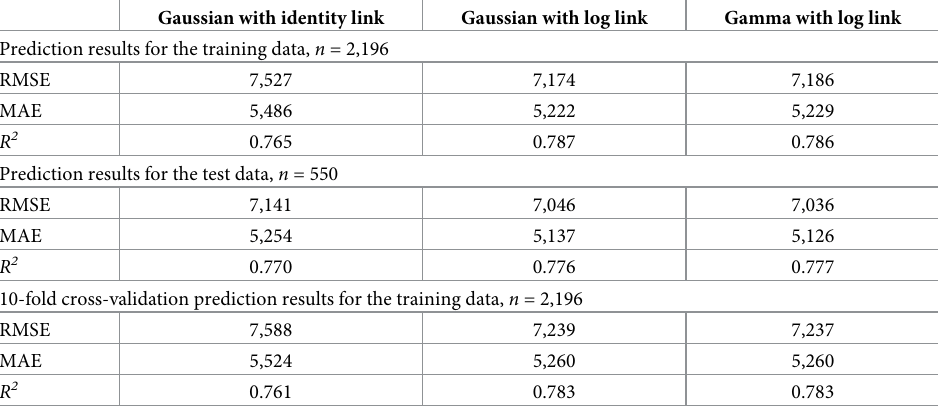
Table 4. Machine learning model prediction results for Hawaii longline fishery tip cost models. Gaussian with identity link Gaussian with log link Gamma with log link Prediction results for the training data, n = 2,196